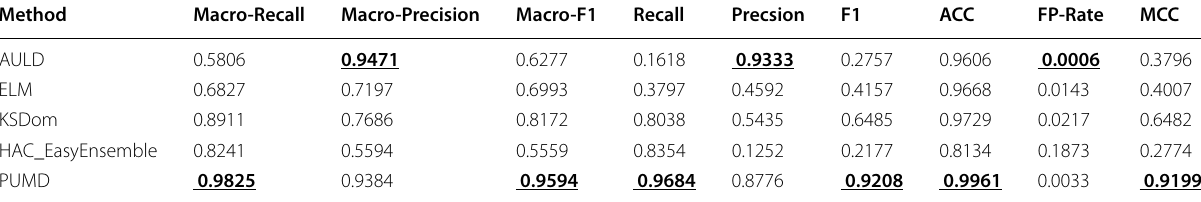
Underlined value : overall best performance